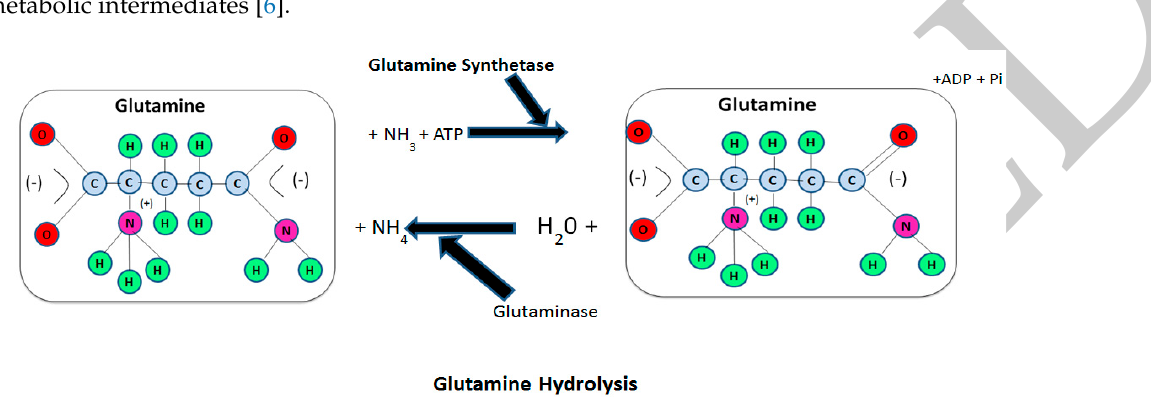
Figure 1. Synthesis and hydrolysis of Glutamine. Glutamine is mostly synthesized and hydrolyzed through the enzymes glutamine synthetase (GS) and glutaminase (GLS), respectively. GS catalyzes glutamine biosynthesis through ammonia and the glutamate source. In response, one